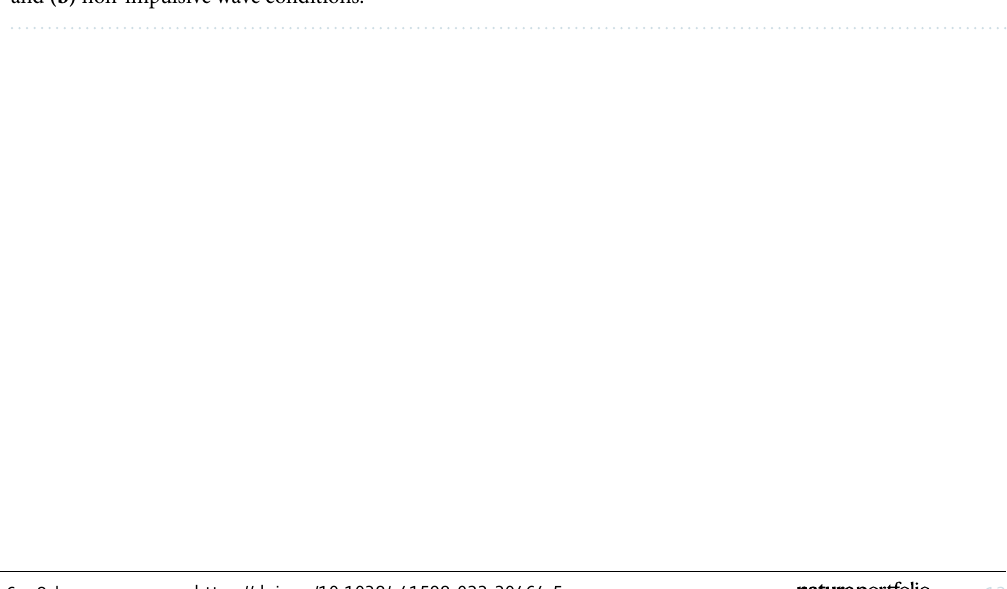
Figure 9. Influence of relative overtopping discharge on Weibull b parameters: (a) impulsive wave conditions and (b) non-impulsive wave